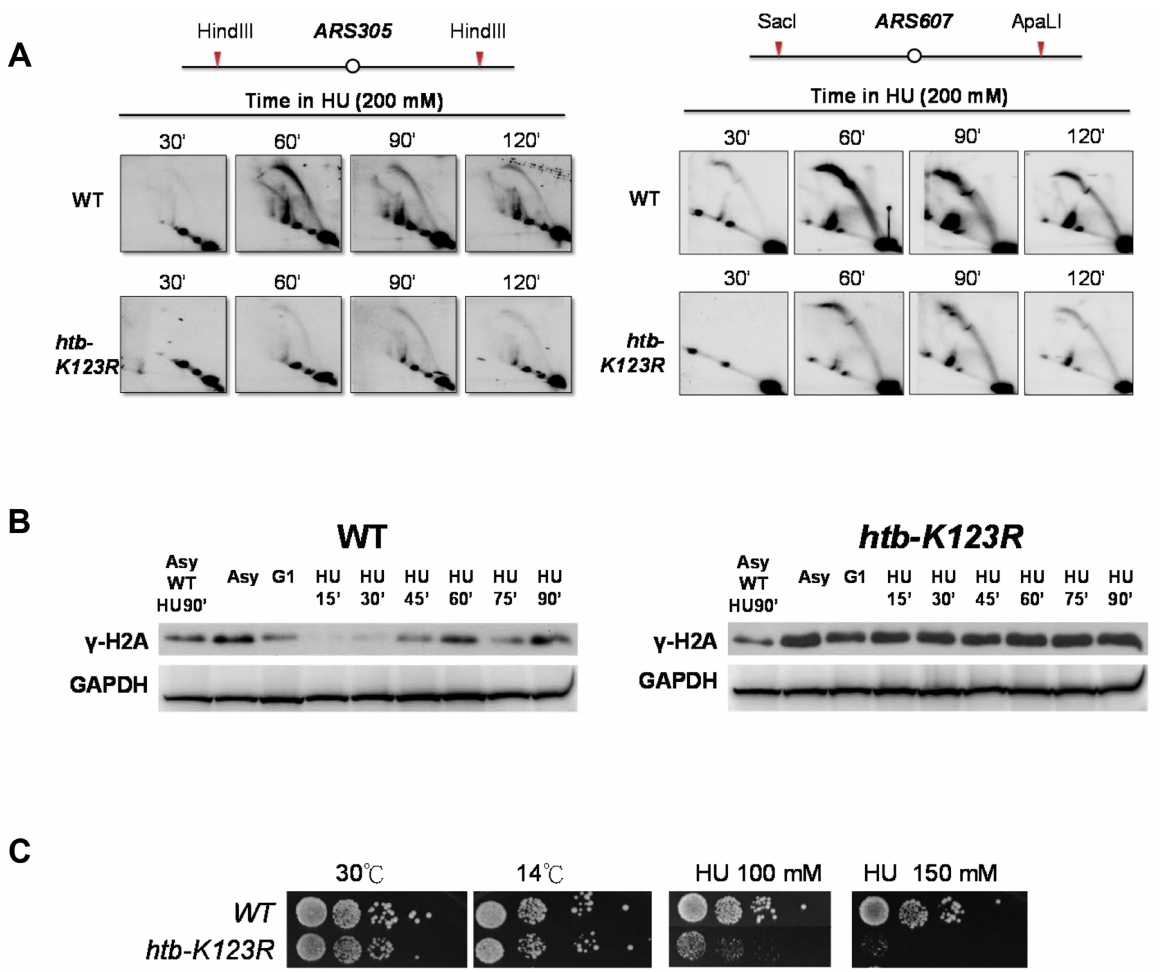
Figure 3. H2Bub preserves replication fork stability under HU stress. (A) Analysis of replication intermediates (RIs) at ARS305 and ARS607 in WT (CFK1204) and htb-K123R (CFK1231) mutants. Cells were synchronized at G1 phase and released into media containing 200 mM HU for 120 minutes. DNA was prepared from cells collected at the indicated times, cut with HindIII ( ARS305 ) or SacI and ApaL1 ( ARS607 ), and analyzed by 2D gel using the ARS305 or ARS607 probe, as described in the Materials and Methods. (B) Accumulation of damaged DNA in H2Bub-depleted cells. WT (CFK1204) and htb-K123R (CFK1231) cells were arrested in G1 and released into fresh media containing 0.2M HU for 90 minutes at 30 u C. Whole cell lysates were prepared at the indicated time points, and analyzed by Western blot using antibodies against c -H2A, a marker of DNA damage. G6PDH was used as a loading control. Asy: Asynchronized cells. (C) Cells lacking H2Bub are more sensitive to replication stress. Ten-fold serial dilutions of yeast cells (WT (CFK1204) and htb-K123R (CFK1231)) were spotted onto nonselective YPD plates under different temperatures or YPD containing 100 or 150 mM HU for a period of several days.